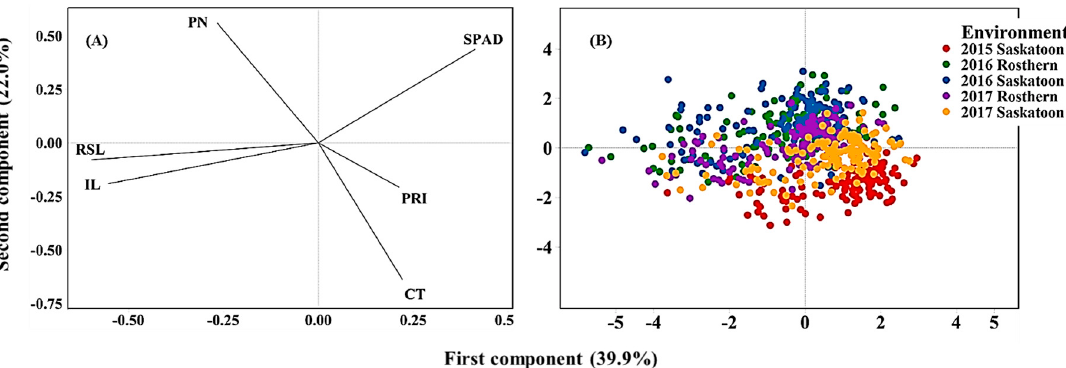
Figure 4. Loading ( A ) and Score ( B ) plots of principal component analysis illustrating the overall association of traits and genotype performance across environments. Note: PN, pod number; RSL, reproductive stem length; IL, internode length, CT, canopy temperature; PRI, photochemical reflectance index.